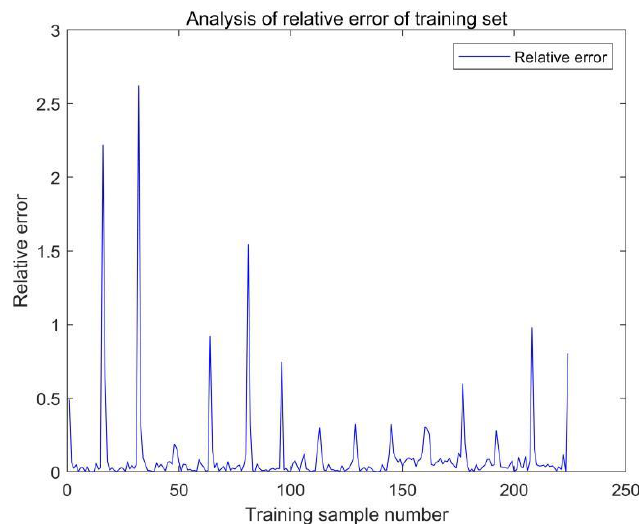
Figure 33. The relative error plot of the training set.